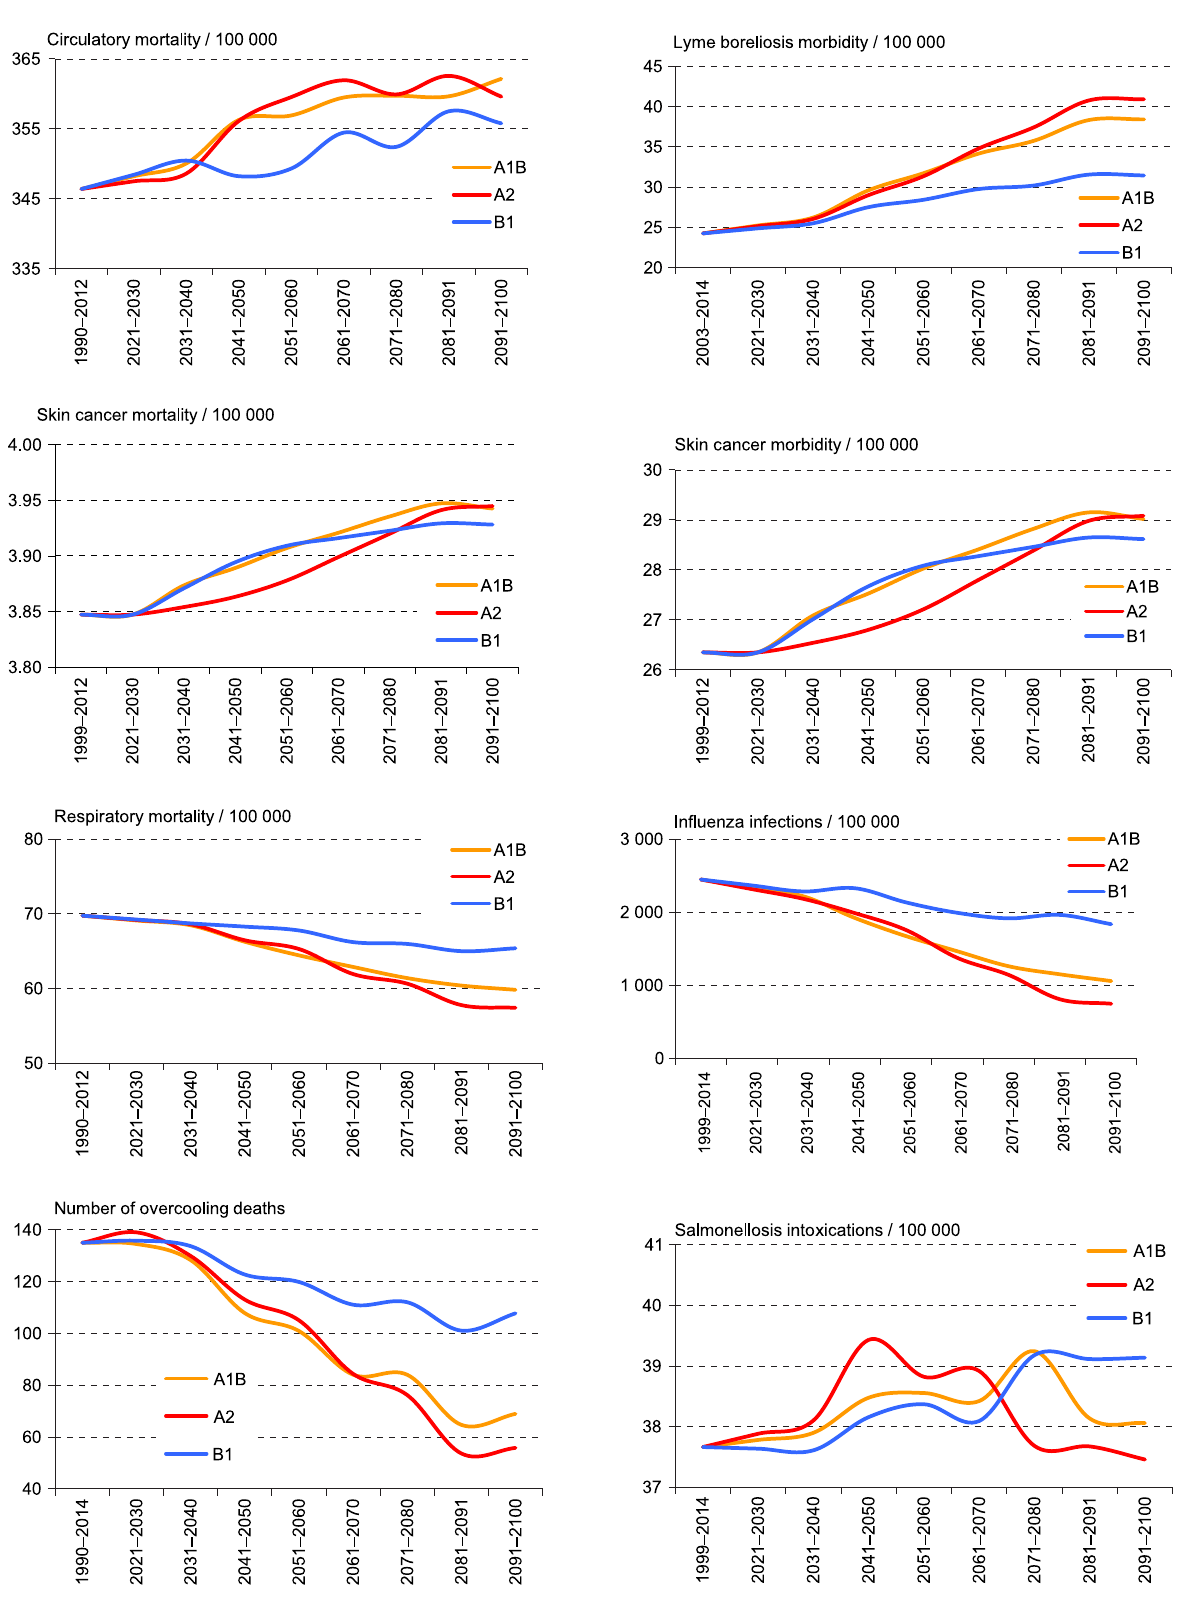
Fig. 6. Projected, for the consecutive decades of 21 st century, CRD indicators: circulatory mortality, Lyme boreliosis infections, skin cancer mortality, skin cancer morbidity, respiratory mortality, influenza morbidity, overcooling deaths, salmonellosis